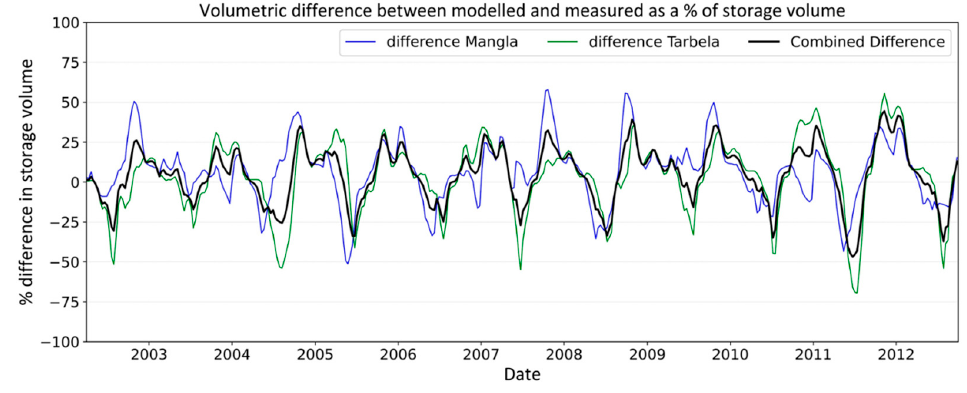
Figure 10. Volumetric difference between modelled and measured as a percentage of storage vol- ume.